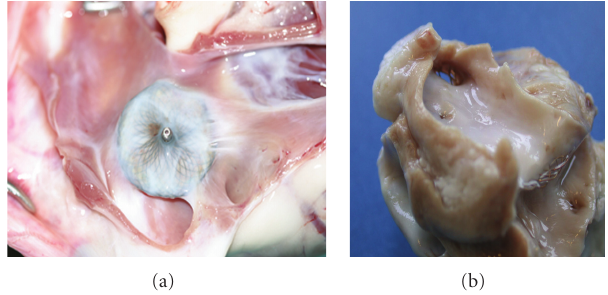
Figure 3: Macroscopic aspect of the right atrial disc (a), and the left atrial disc (b) of an explanted Occlutech Figulla PFO device after an implantation time of 12 weeks. Both discs are completely covered by fibrous tissue without any thrombus deposition.